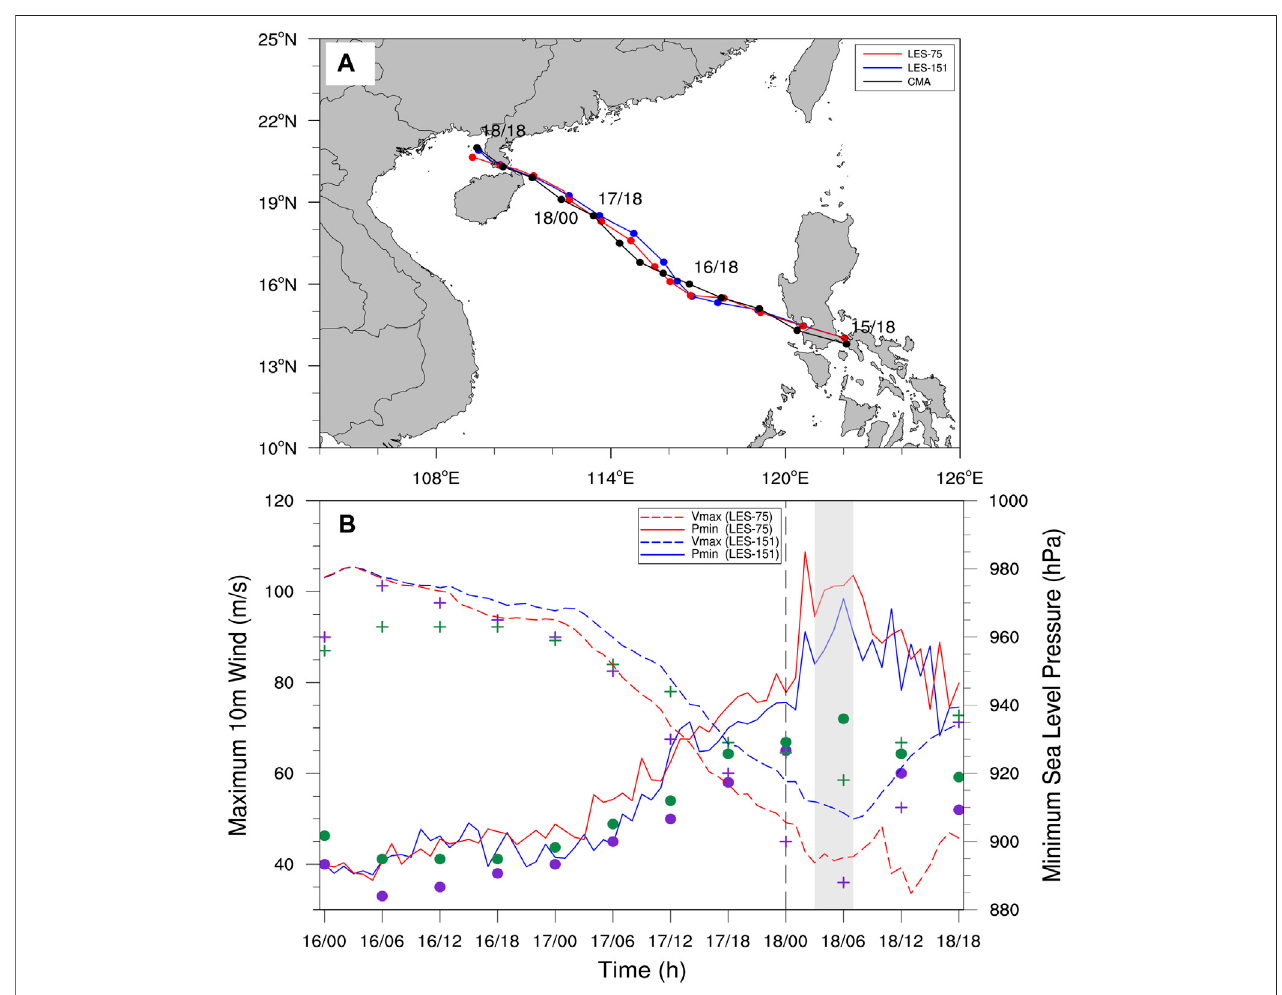
FIGURE 1 | Comparisons of the observed and simulated (A) tracks and (B) intensities of Super Typhoon Rammasun (2014). The time is in the dd/hh format. The observed track is from the CMA best track dataset, while the observed intensities are from the CMA best track dataset (purple dots and crosses) and the JTWC best track dataset (green dots and crosses) in terms of minimum sea-level pressure (crosses, units: hPa) and maximum instantaneous wind speed at 10 m (dots, units: m s − 1 ). The time intervals are 6 h from the observation and 1 h for the simulation. The gray shading area is the range of analysis times and the black dashed line indicates the activation of D05 and D06